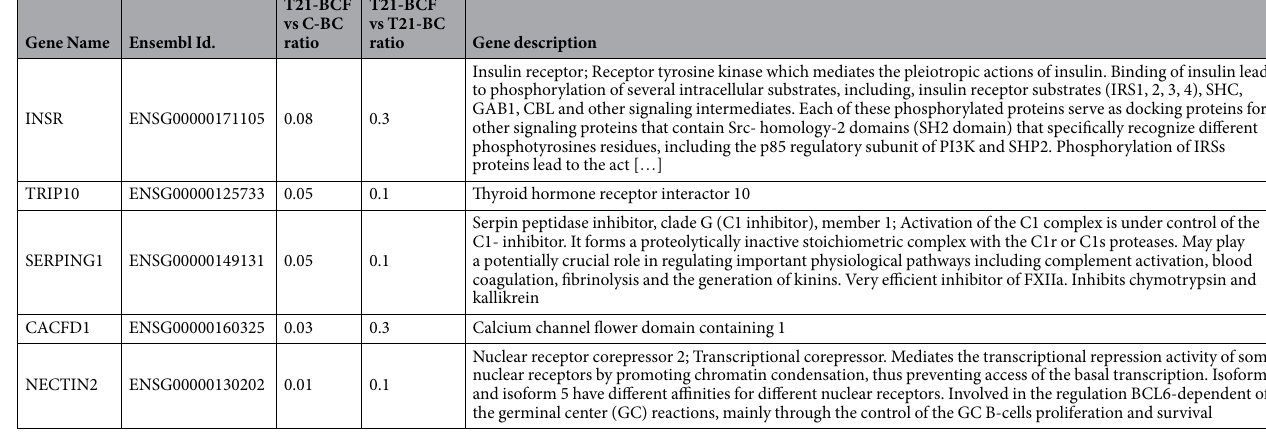
Table 1. List of the 63 genes showing the same regulation profile between groups A (T21-BCF versus C-BC) and B (T21-BCF versus